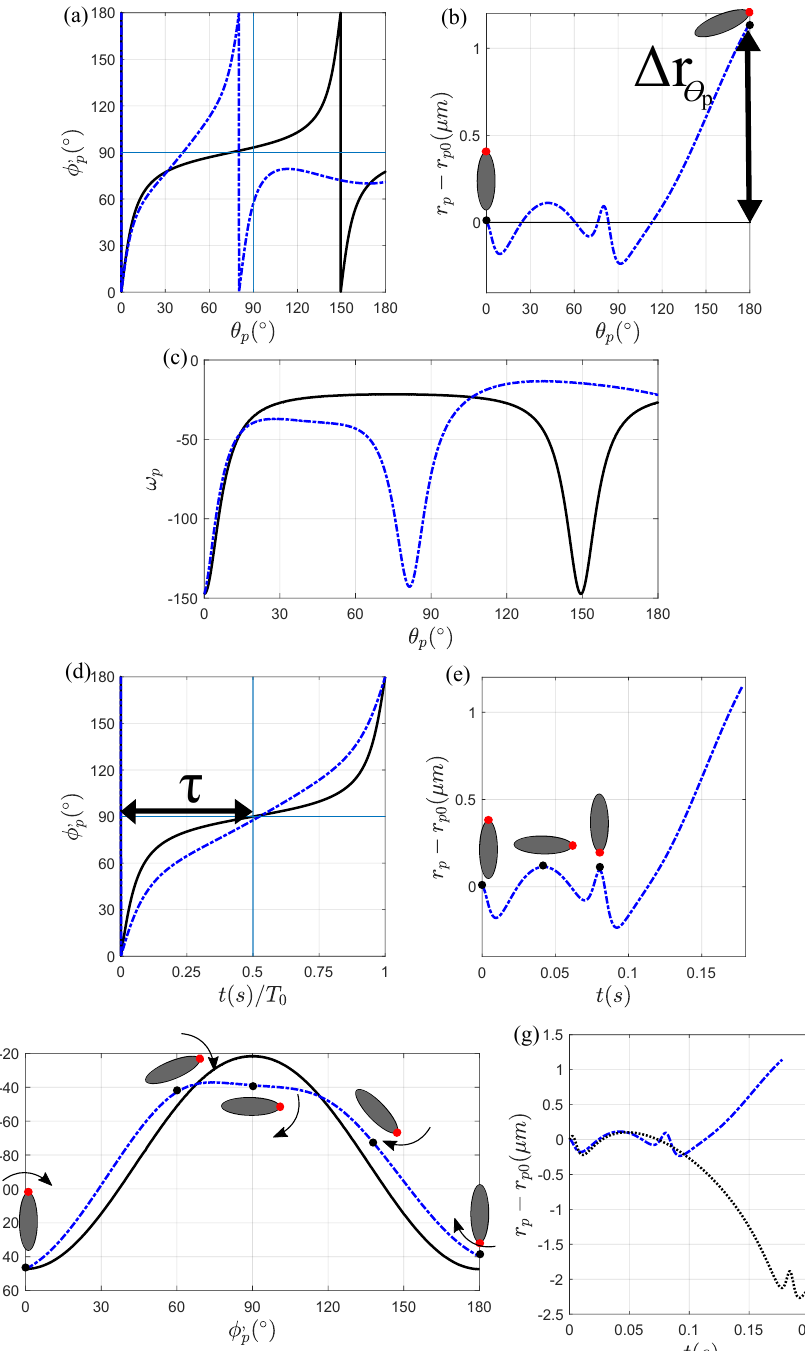
Figure 4. Particle dynamic and transportation comparison between H 0 = 0 A/m (solid black line), and H 0 = 3000 A/m applied at α = 90 ◦ (dot-dash blue line) for ( a ) the particle’s rotation, ( b ) the radial migration, and ( c ) the angular velocity in terms of θ p ; ( d ) the particle’s rotation, ( e ) the radial migration, ( f ) the angular velocity in terms of time t , and ( g ) comparison between the particle-wall distances in a straight channel (dot black line) and in a curved channel (dot-dash blue